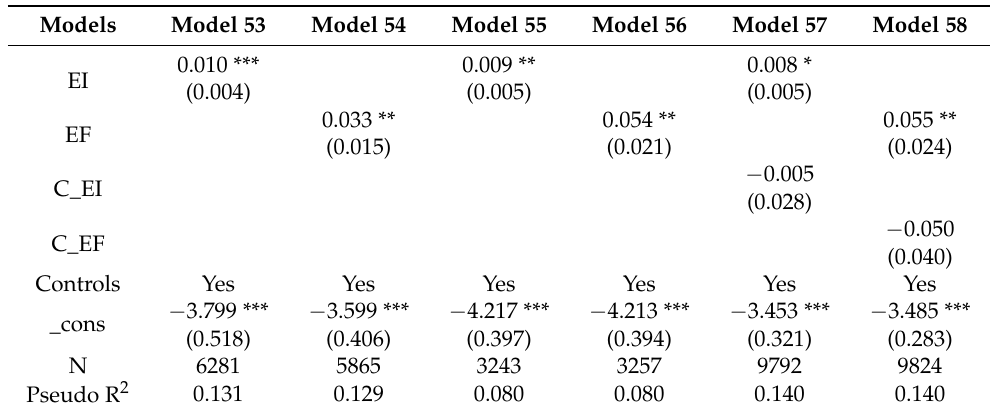
Table 11. CEM, reduced sample test, and copulas